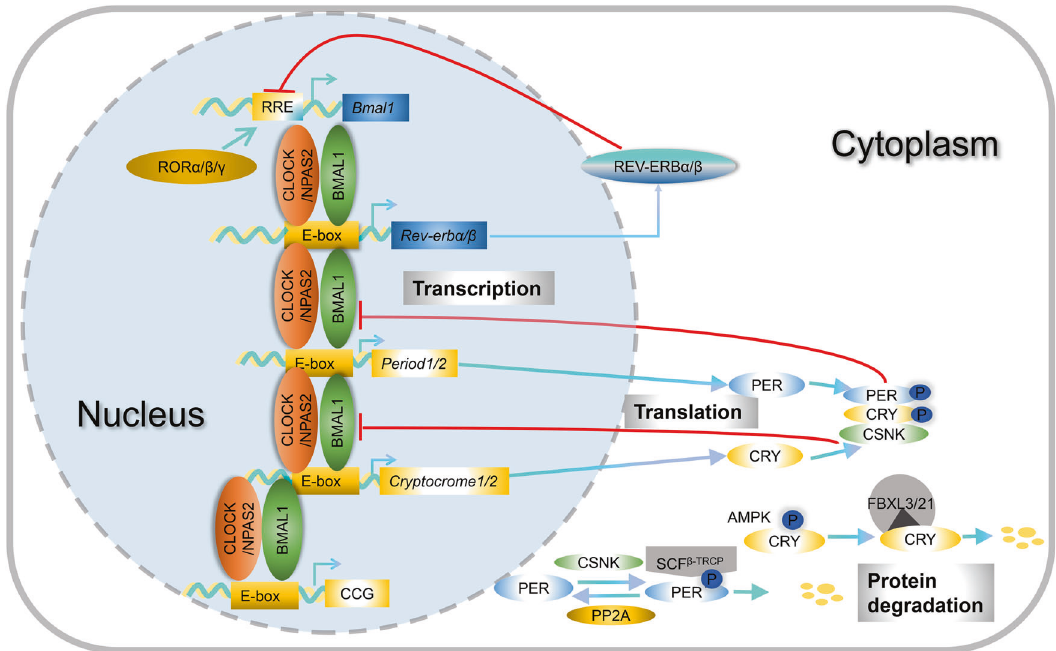
Fig. 2 The molecular mechanisms of mammalian circadian timekeeping through the autoregulatory transcriptional-translational feedback loops. The transcription factors CLOCK (or NPAS2) and BMAL1 form heterodimers, which bind to the cis -acting element E-box and activate the expression of Period1/2 and Crypotochorme1/2 . PER and CRY proteins form multiprotein complexes in the cytoplasm. Once accumulating to a certain level, the PER/CRY complexes translocate into the nucleus, interact with the CLOCK: BMAL1 complex, and repress their own gene transcription. The CLOCK: BMAL1 complex also promotes the transcription of Rev-erb α / β . REV-ERBs inhibit the Bmal1 transcription whereas RORs promote Bmal1 transcription. PER protein abundance is controlled at the mRNA translation level via an elF4E- dependent mechanism. CRY is phosphorylated by AMPK and PER by CSNK. The levels of CRY and PER are also regulated by phosphorylation and ubiquitin-medicated protein degradation at the post-translational levels. The CLOCK: BMAL1 complex also regulates numerous clock- controlled genes via the E-box